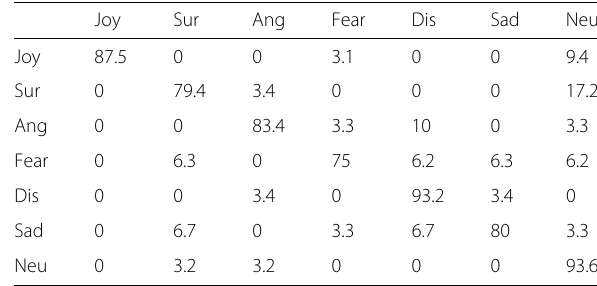
Table 14 Confusion matrix (%) of leave-one-out testing method for 7-class emotion in JAFFE dataset using Improved GLTP